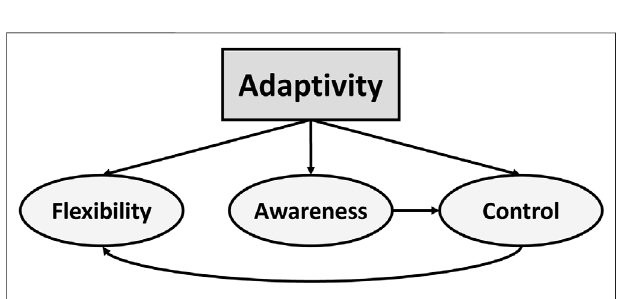
FIGURE 3 | Building blocks of